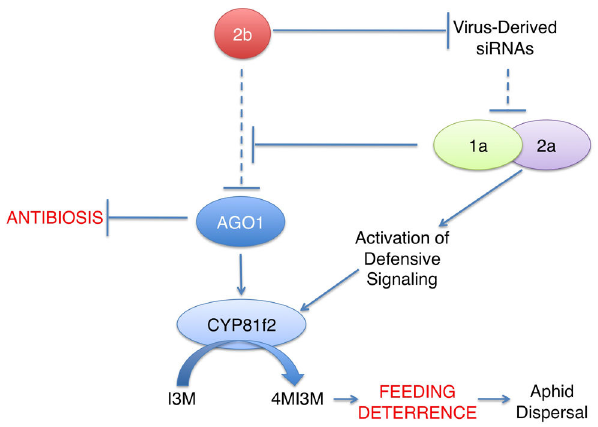
Figure 10. Induction of aphid feeding deterrence and avoidance of aphid antibiosis induction during CMV infection. The 2b RNA silencing suppressor protein of CMV inhibits antiviral silencing through binding of virus-derived siRNAs, allowing viral gene products [41], including the 1a and 2a replicase proteins, to accumulate. The 2b protein can also bind to and inhibit AGO1 [32], which positively regulates expression of the gene for CYP81F2, which catalyzes formation of the aphid feeding deterrent compound 4-methoxy- indol3yl-methylglucosinolate (4MI3M) from its precursor regulates induction of a toxicity-based resistance to aphids (antibiosis). The 1a replicase protein appears to be able to moderate 2b inhibition of AGO1 by the 2b protein, preventing induction of antibiosis and preventing inhibition of 4MI3M signaling, which results in stimulation of CYP81F2 expression and increased accumulation of 4MI3M. This results in feeding deterrence (see Figure 1A), which is thought likely to increase aphid dispersal and thus enhance transmission of non- persistently aphid-transmitted viruses like CMV (Reviewed in reference [4]). In this diagram dashed lines represent